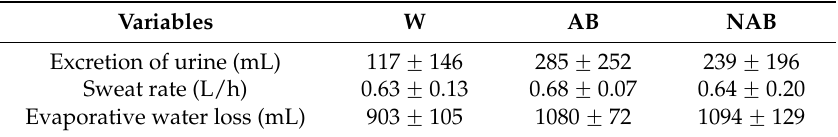
Table 4. Effects of water (W), alcoholic (AB) or non-alcoholic beer (NAB) intake on excretion of urine, sweat rate, and evaporative water